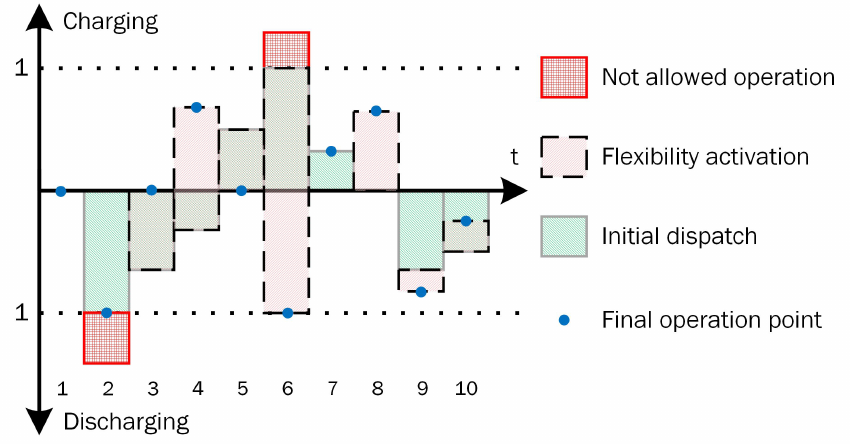
Figure A1. ES initial and final